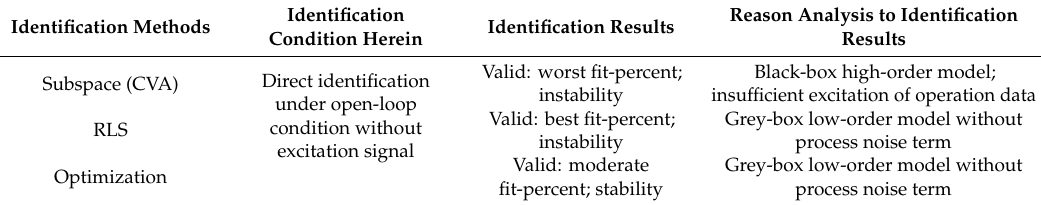
Table 8. Comparison analyses of identification results for tower